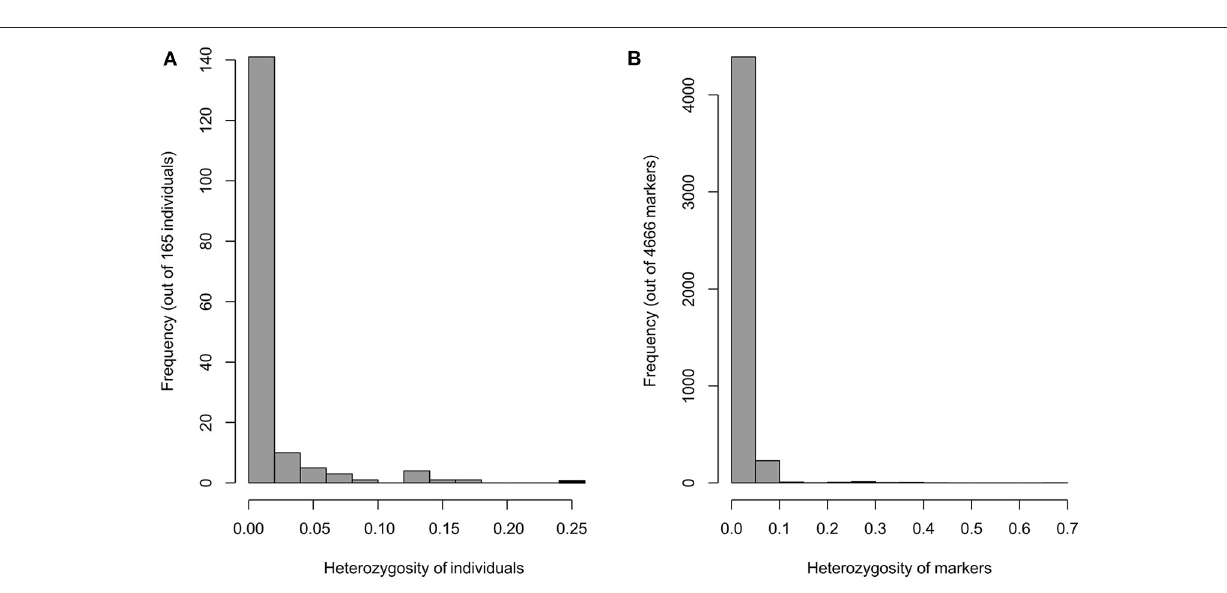
Frontiers in Agronomy |